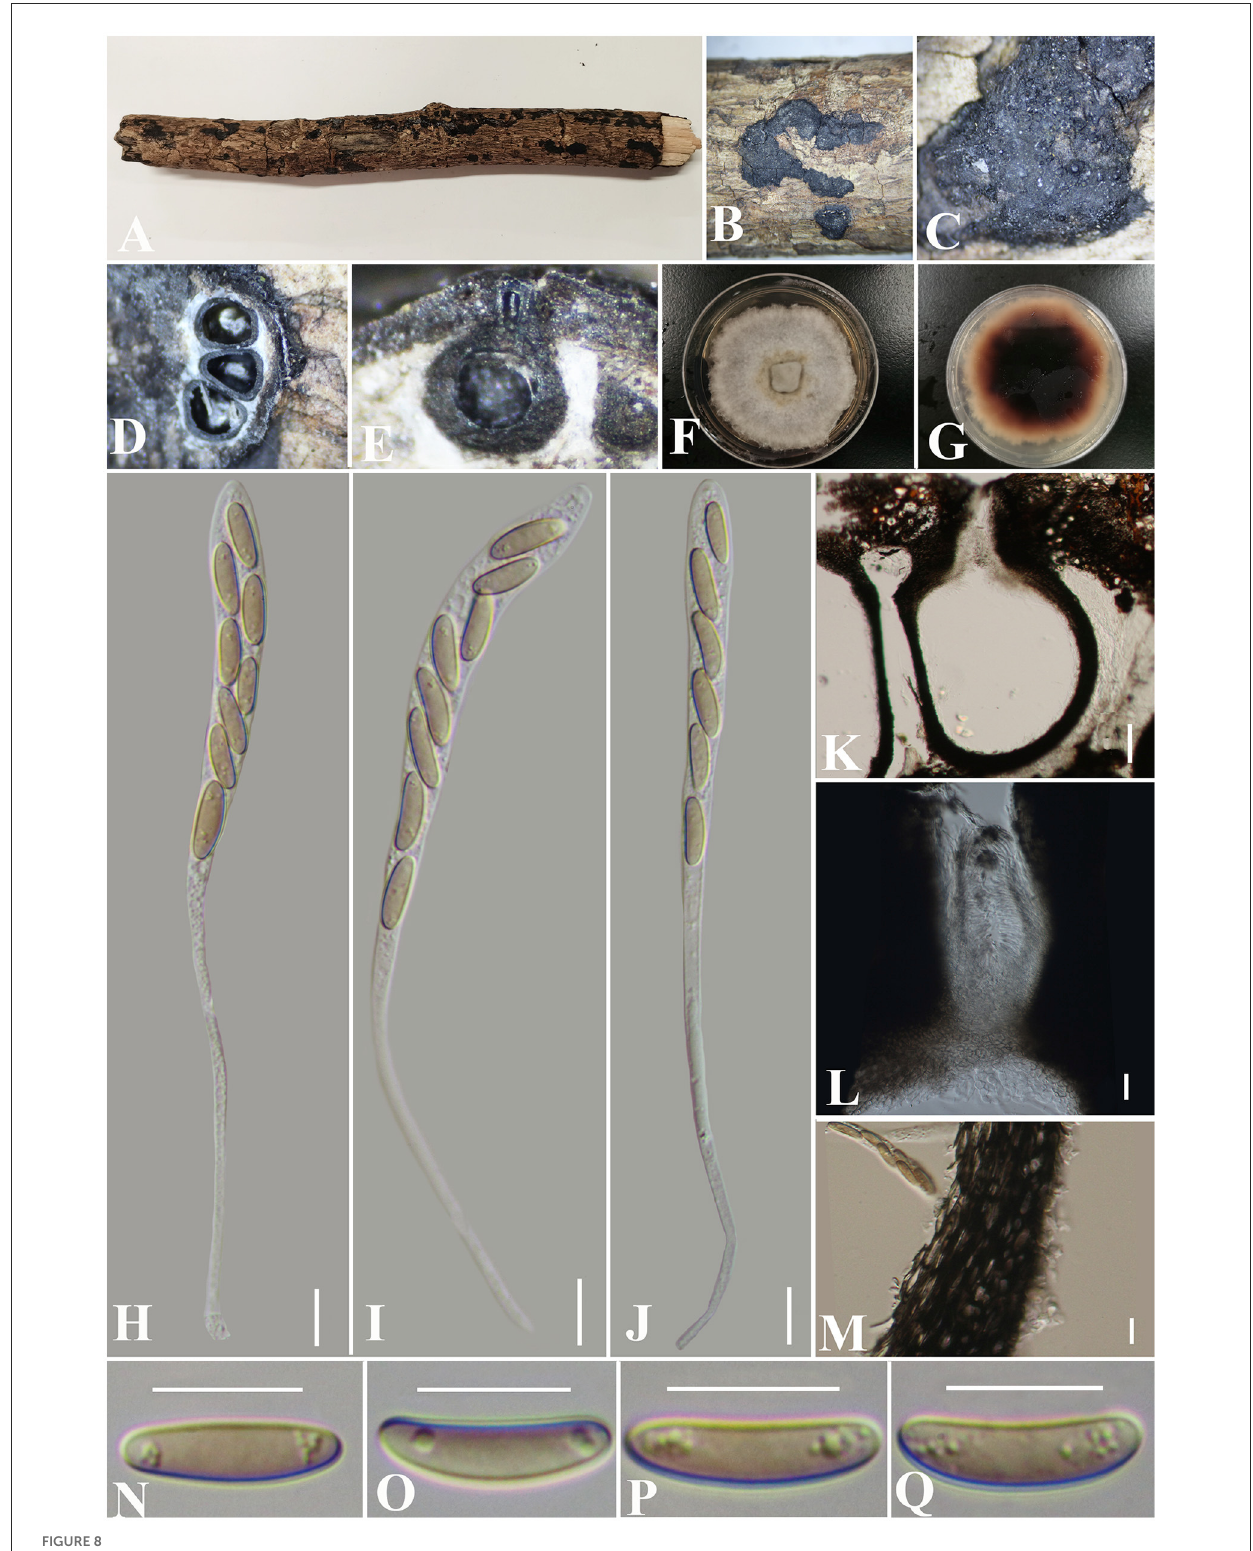
FIGURE8 Diatrypella fatsiae-japonicae (GMB0422, holotype). (A) Type material. (B, C) Close-up of stromata. (D) Transverse section through stromata. (E) Vertical section through stromata. (F, G) Cultures on PDA. (H–J) Asci. (K) Section through the ascostroma. (L) Ostiolar canal. (M) Peridium. (N–Q) Ascospores. Scale bars: (H–J, L–Q) = 10 µ m; (K) = 50 µ